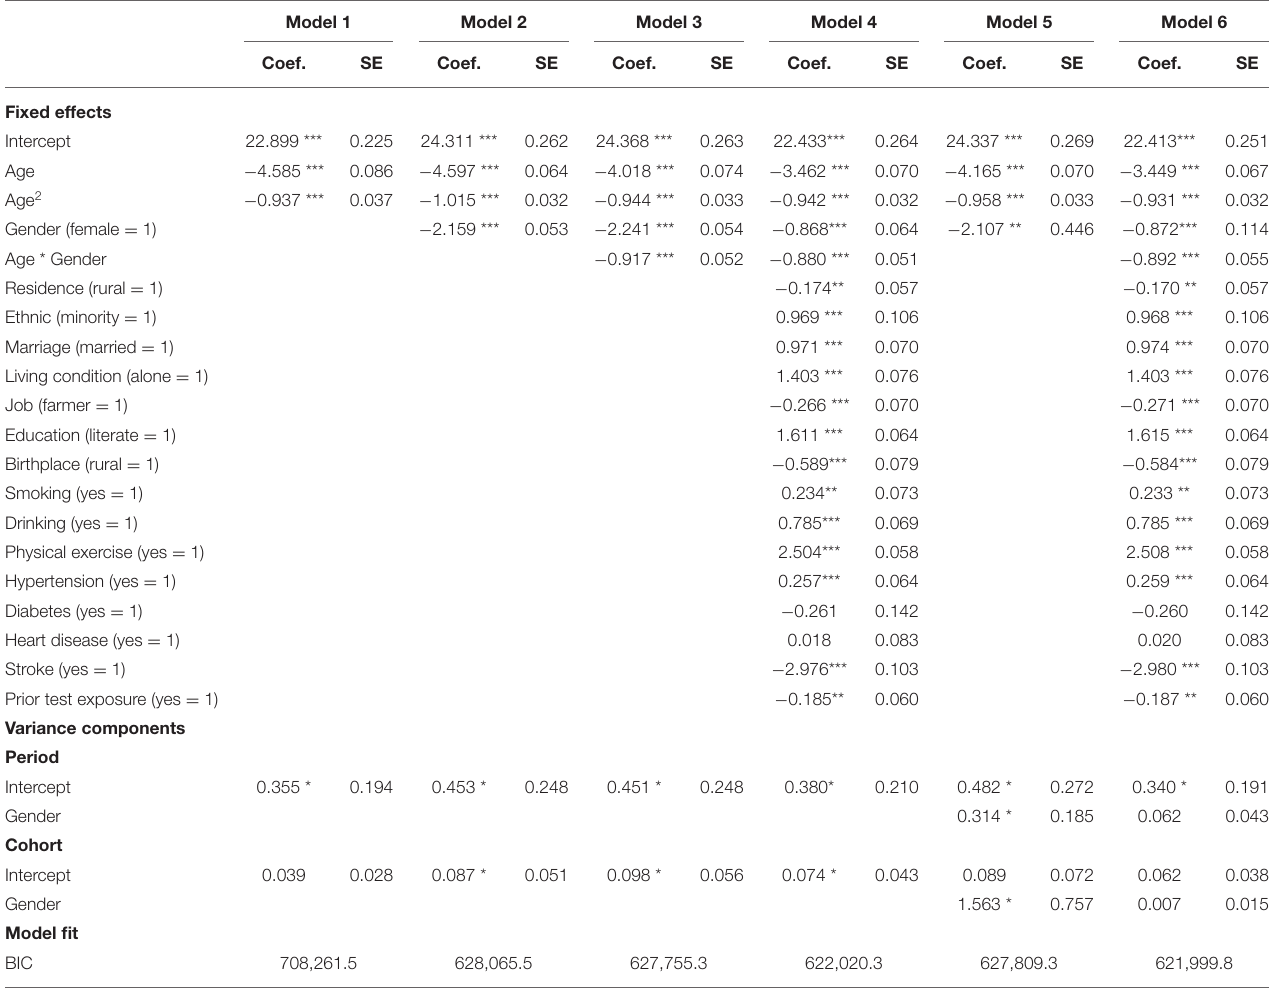
TABLE 2 | Hierarchical age–period–cohort cross-classified random-effect model estimates of MMSE scores. Model 1 Coef. SE Coef. SE Coef. SE Coef. SE Coef. SE Coef.